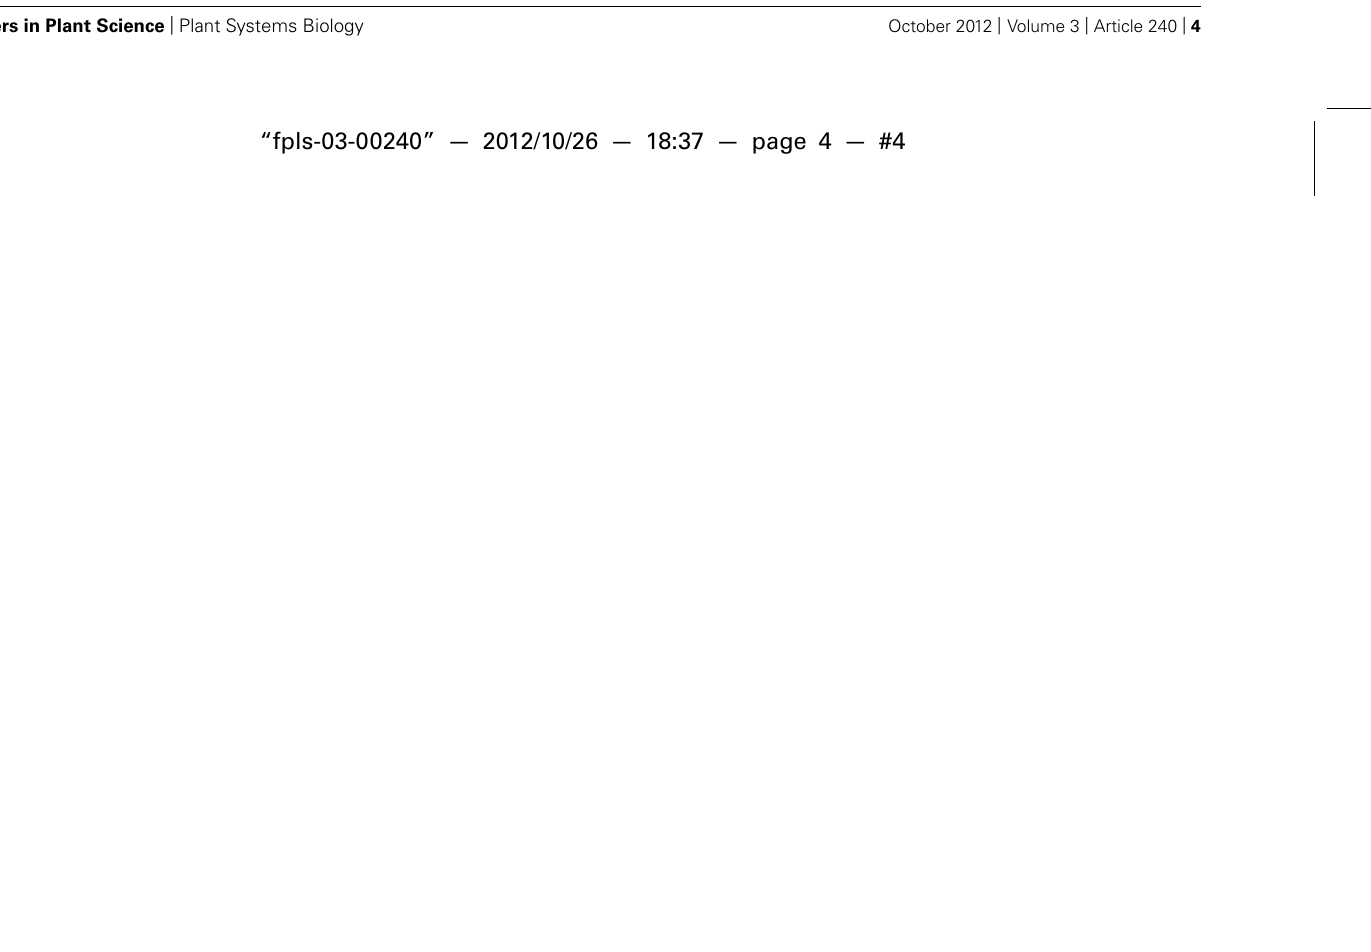
the average expression level of the same genes in purified mesophyll and guard cells treated with 100 μ M ABA for 4 h (Yang etal., 2008).The genes for different proteins exhibit stronger expression levels in these distinct tissues, highlighting potential protein–protein interaction subnetworks in these different kinds of tissues. Gray nodes denote that no expression information is